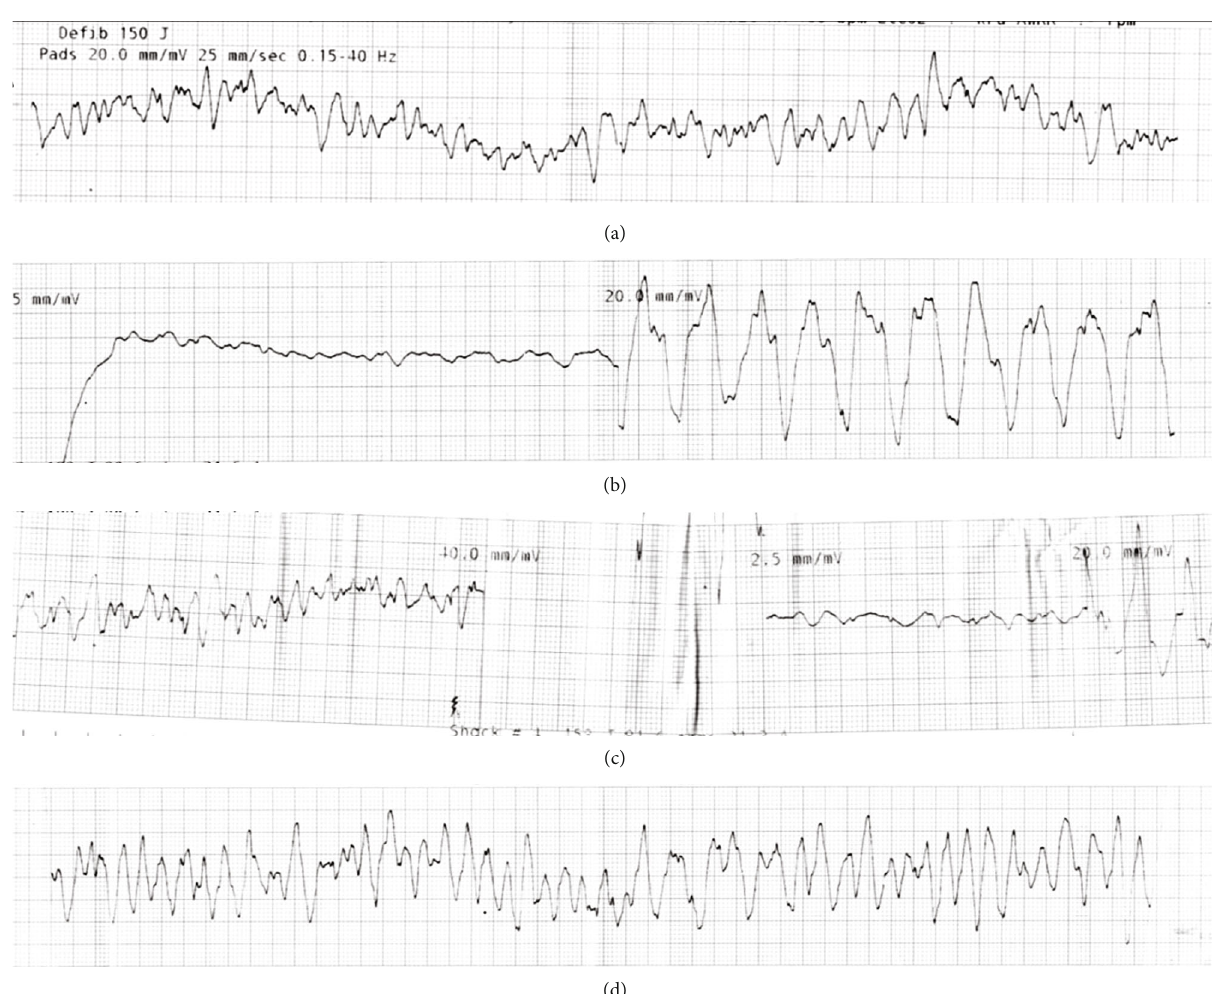
Figure 2: Cardiac arrest rhythm strips. (a) First rhythm strip with ventricular fi brillation identi fi ed prior to the fi rst shock. (b) Asystole following de fi brillation, this is followed by the arrest team resuming chest compressions. (c) Ventricular fi brillation again during later rhythm check, followed by de fi brillation, asystole again, and resumed chest compressions. (d) Further alternation with ventricular fi brillation after prolonged